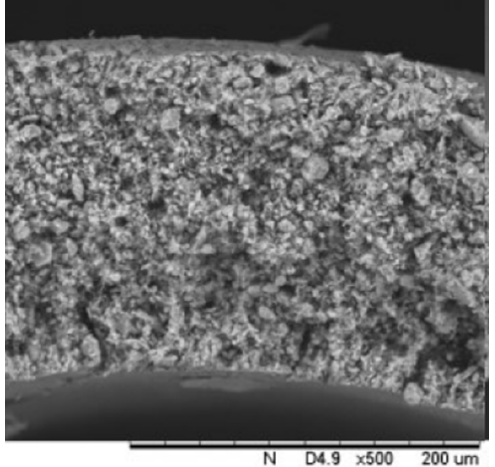
Figure 4. Cross-section SEM image of mullite tube with open porosity.